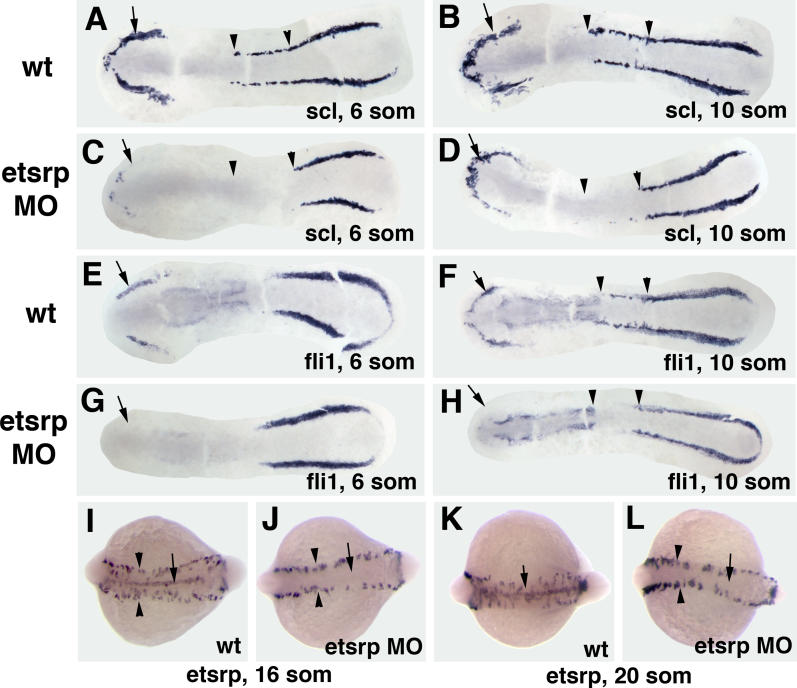
Molecular Analysis of Early Vasculogenesis in etsrp Morphants(A, B, E, F, I, K) Uninjected control embryo; (C, D, G, H, J, L) 8–10 ng etsrp MO2-injected embryo. Anterior is to the left in all panels. (A–H) Embryos were flat mounted with their yolk removed. (A–D) scl expression; six-somite (A,C) and ten-somite (B,D) stages. Note that the anterior domain of scl expression (arrows) is reduced and the trunk domain (arrowheads) is missing in etsrp morphants. (E–H) fli1 expression; six-somite (E,G) and ten-somite (F,H) stages. Note that the anterior domain of fli1 expression (arrows) is missing in the etsrp morphants, while the posterior domain is not affected. Also note that the trunk domain of fli1 expression (arrowheads, F,H) is missing at the ten-somite stage in etsrp morphants. (I–L) Etsrp knockdown blocks angioblast migration towards the midline as assayed by etsrp expression at the 16-somite (I,J) and 20-somite (K,L) stages. (I,K) Uninjected control embryo; (J,L) 7.5 ng etsrp MO2-injected embryo. Dorsal view, anterior is to the left. Note that the midline stripe of angioblasts (arrows) is missing in etsrp morphants. Also notice more intense etsrp expression in pre-migratory angioblasts (arrowheads) in etsrp morphants as compared to control embryos.